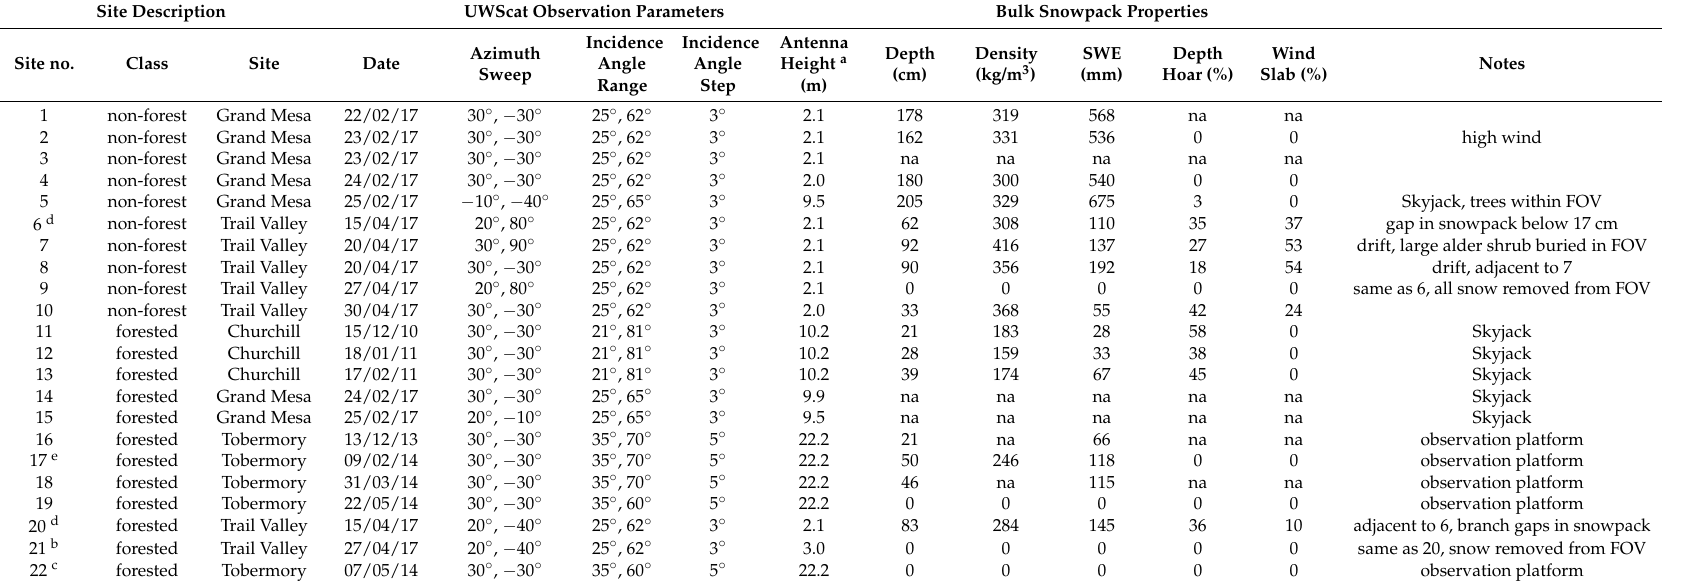
Table 1. Summary of UWScat observation parameters and bulk snowpack